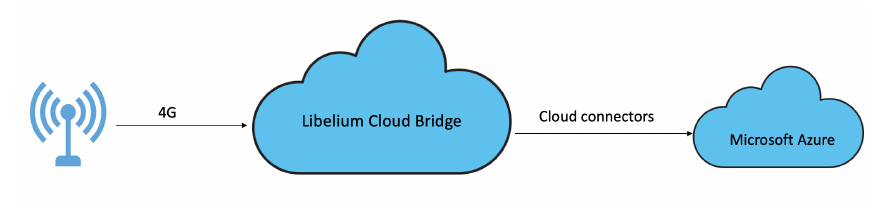
Figure 12. Libelium Cloud Bridge service data flow.